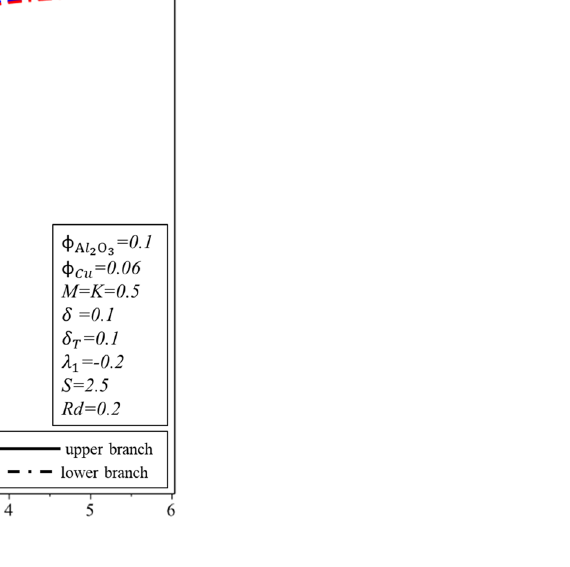
Figure 14. Behavior of f ′ (η) in impact of Pr